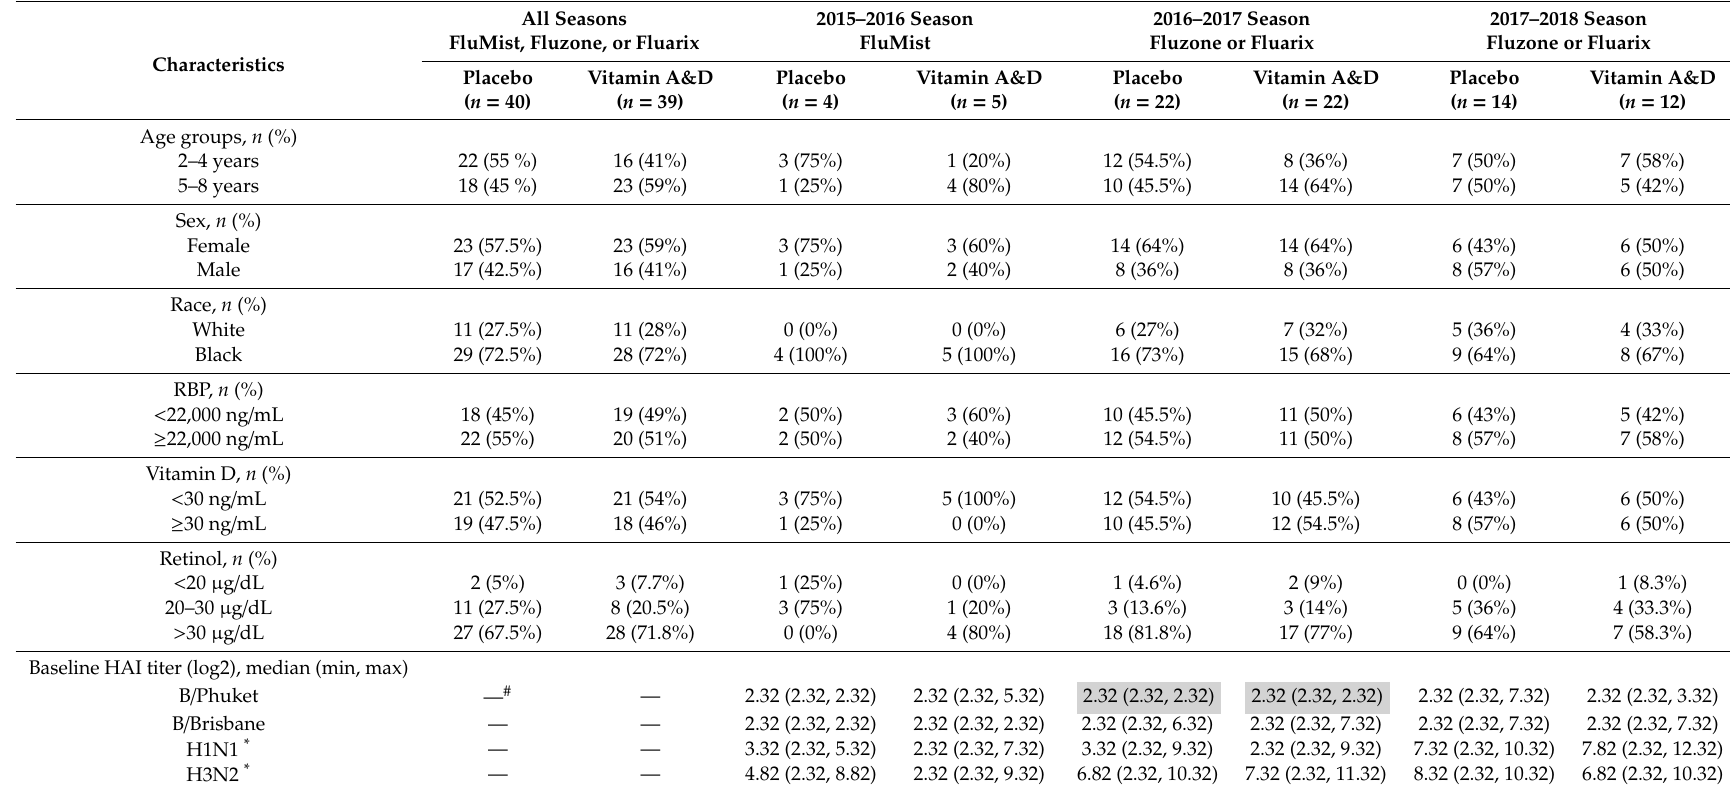
Table 1. Baseline patient